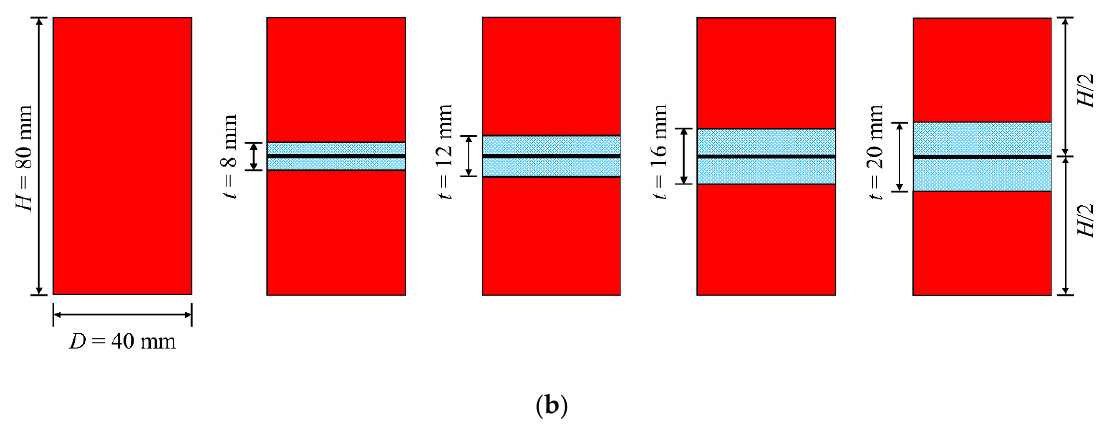
Figure 6. The scheme for the numerical triaxial compression test on the LGSCR samples: ( a ) different numbers of layers; ( b ) different thicknesses of layers.